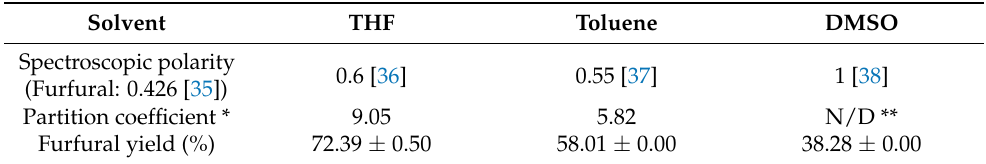
Table 4. Properties of organic solvent and furfural yield from xylose standard based on the type of organic solvent utilized. THF